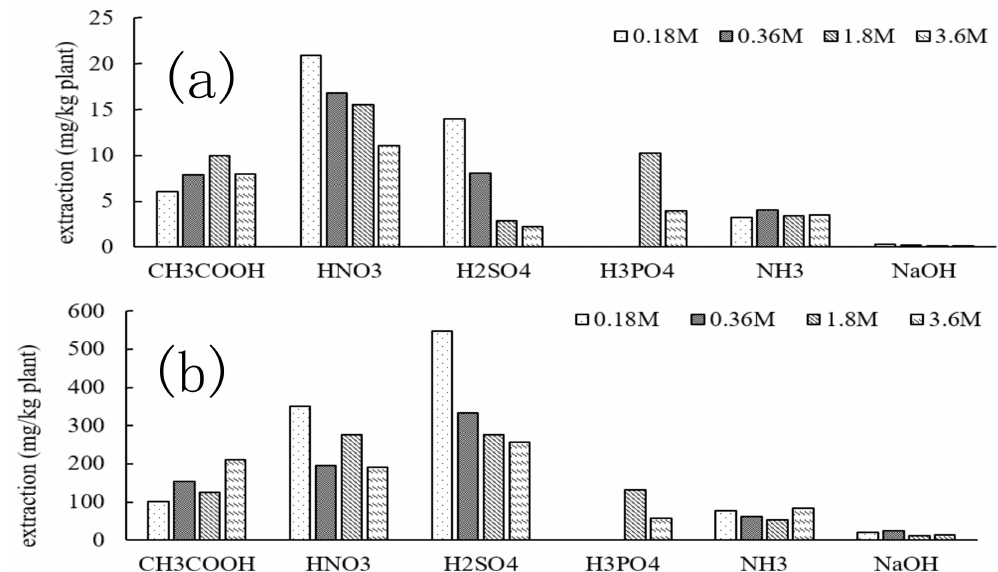
Figure 12. Effect of the solvent on the extraction of ( a ) Cd and ( b ) Zn from Gazania after phytoremediation.